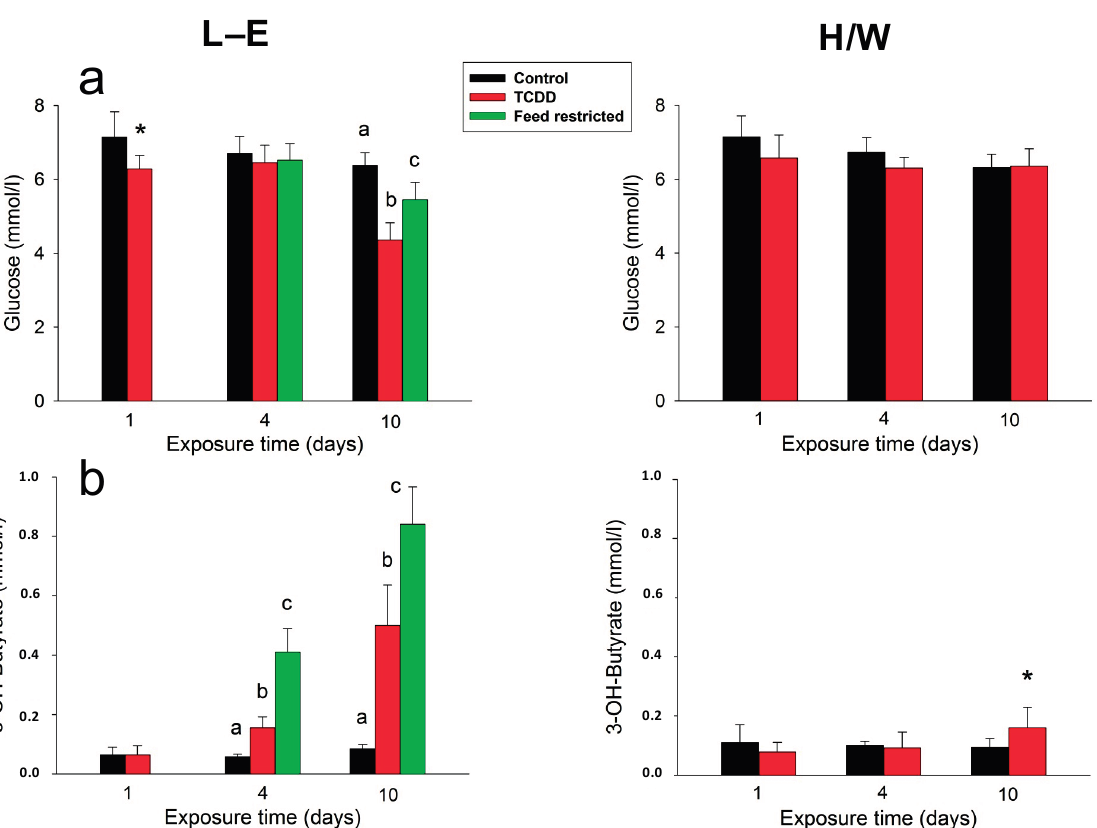
Figure 7. The effect of TCDD or feed restriction on ( a ) serum glucose and ( b ) BHB concentrations in L-E ( left panel) and H/W rats ( right panel) as a function of time (mean ± SD). The conditions are as in Figure